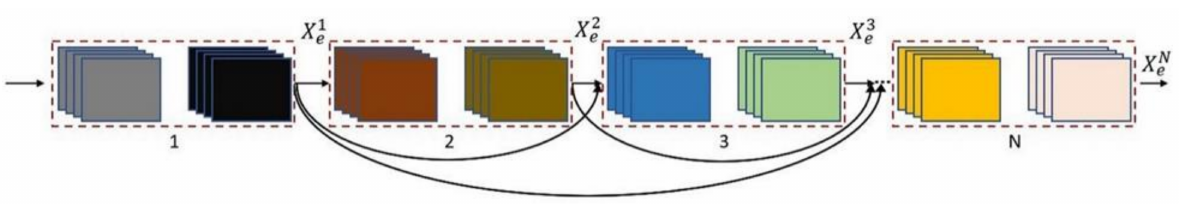
Figure 4. MCG-UNet model with dense connections, with the SE function in the expansive part and BConvLSTM in the skip connections.